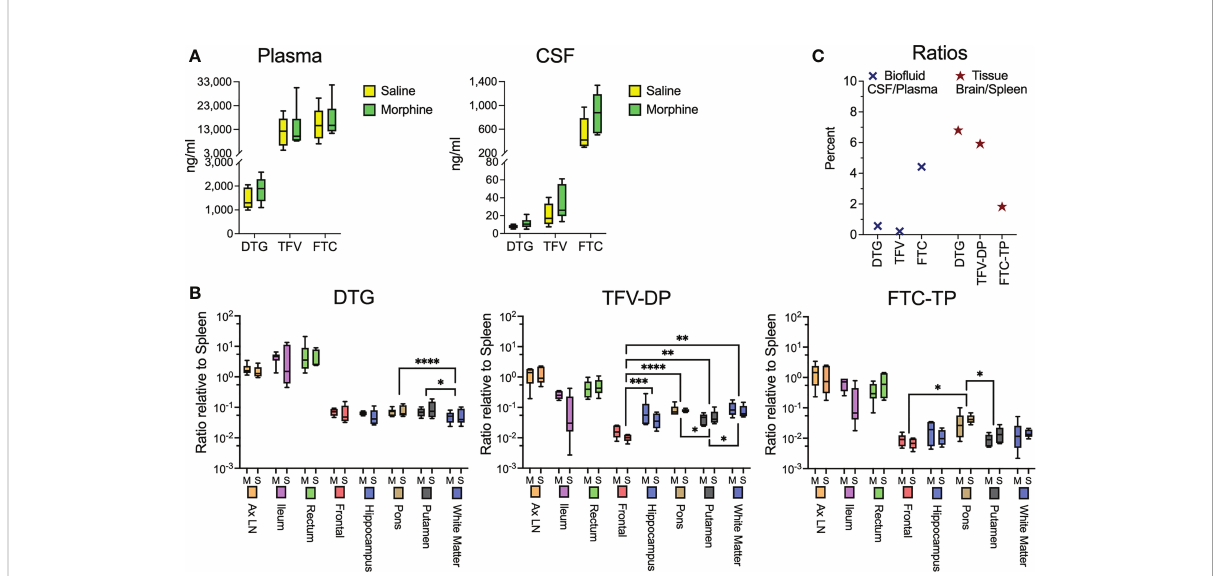
FIGURE 3 Antiretroviral drug measurements in bio fl uids and tissues at necropsy. (A) Concentrations of dolutegravir (DTG), tenofovir (TFV) and emtricitabine (FTC) in the plasma and CSF, 90 minutes after subcutaneous administration of the drugs. (B) Tissue concentrations (with brain regions indicated) of DTG and the active diphosphate (DP) metabolite of TFV (TFV-DP) and triphosphate (TP) metabolite of FTC (FTC-TP). Amounts of these entities were normalized to the amounts found in the spleen of each animal. Statistical testing was done by 2-way ANOVA for the brain region only. When the ANOVA was signi fi cant, testing on the individual regions was performed using Sidak ’ s multiple comparison test. * = <0.05, ** = < 0.01, *** = < 0.001, **** = <0.0001. (C) Ratio of the concentrations found in CSF relative to spleen (left) and of the average of the 5 brain regions relative to spleen